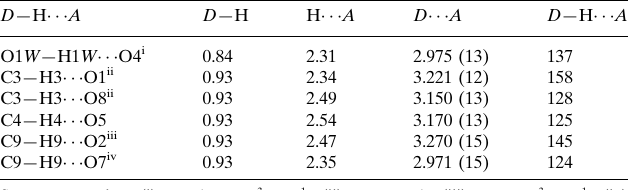
Hydrogen-bond geometry (A˚ , (cid:3)